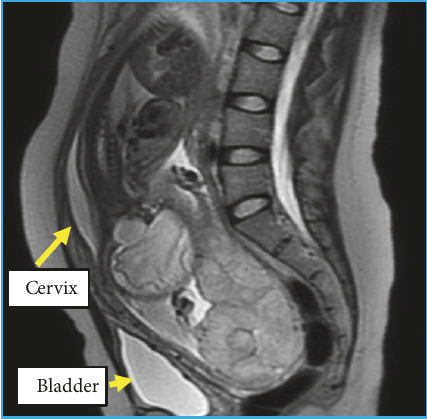
Figure 1: Magnetic resonance imaging scan at 31 weeks and 2 days of gestation.